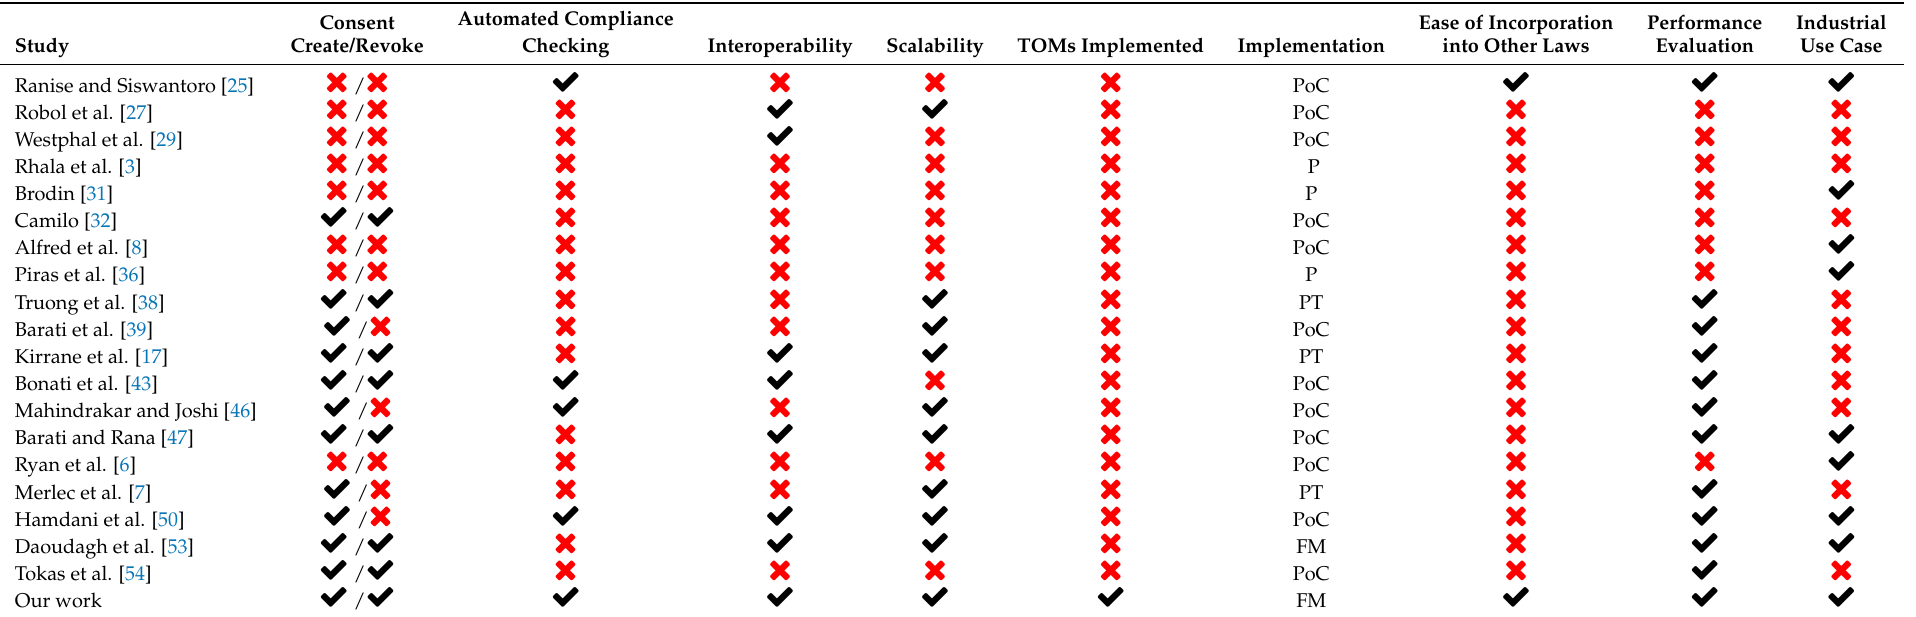
Table A1. Comparison of our automated GDPR compliance verification tool with reviewed